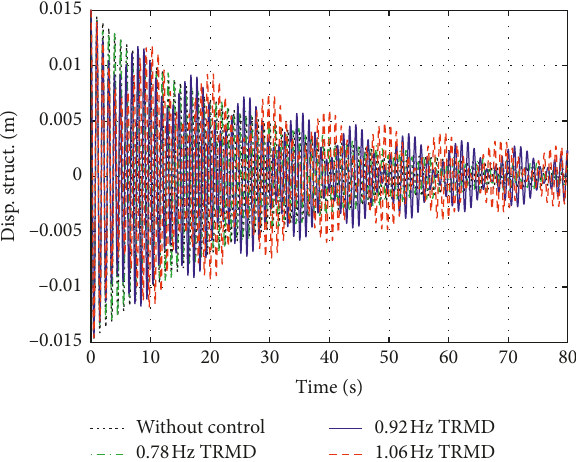
Figure 20: Response of structure controlled by TRMD with dif- ferent frequencies for forced vibration.